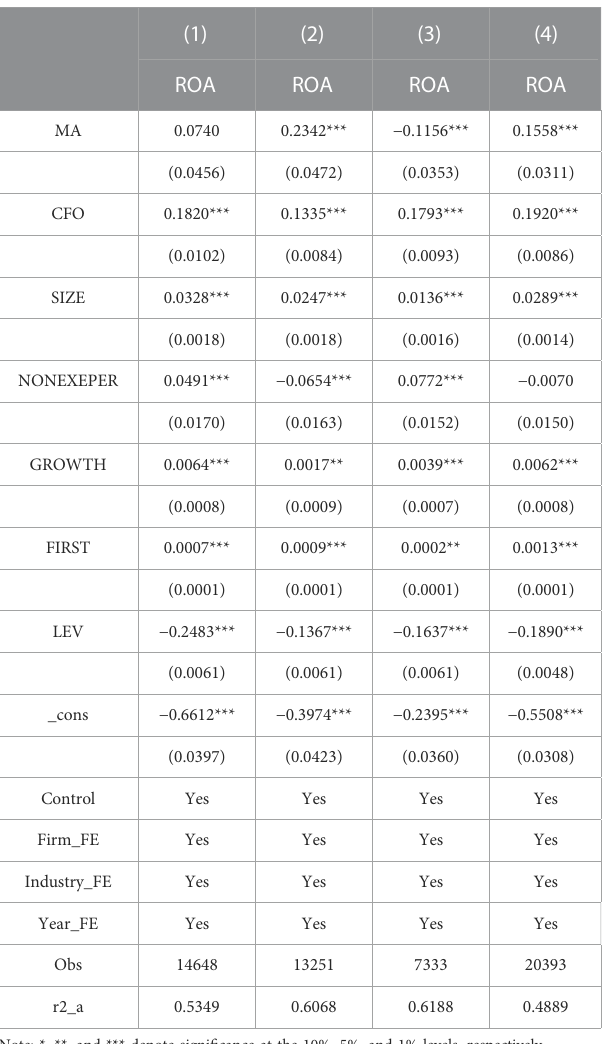
TABLE 4 Robustness test